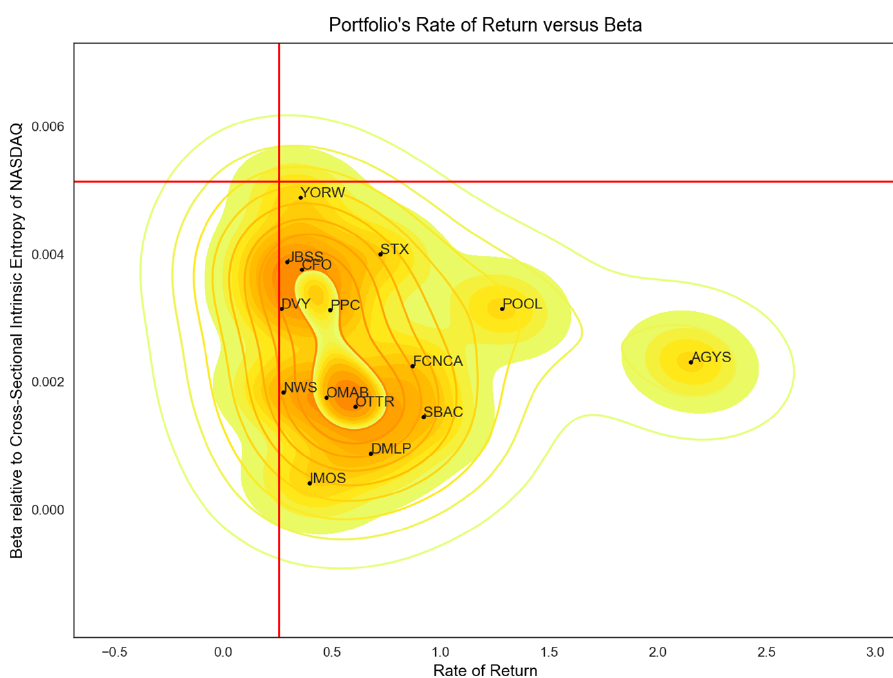
Figure A6. A set of 15 NASDAQ symbols that outperformed the Russell 2000 index in terms of rate of return without being exposed to higher risk (950-day trading interval, from 2 April 2018 to 26 August 2022).